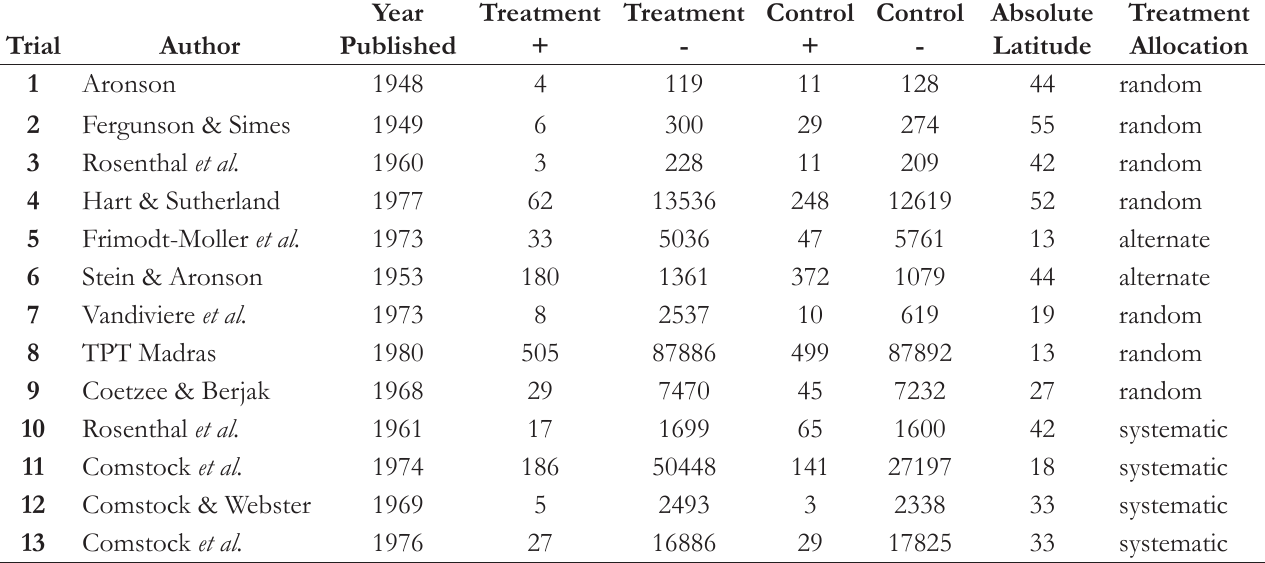
Table 1. Data Source